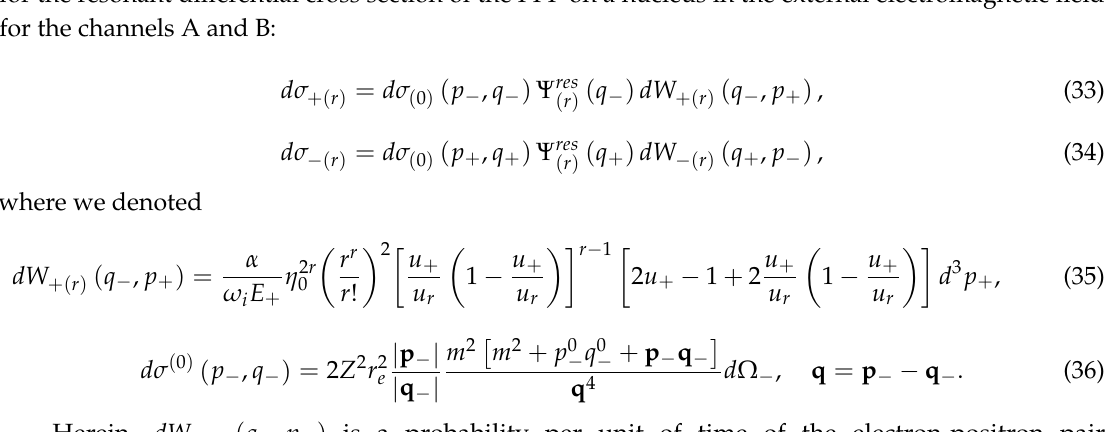
(56) on the parameters δ 2 ± for the first three resonances ± ( r ) (cid:16) (cid:17) ω i > ω thr ( 1 ) = 250 MeV